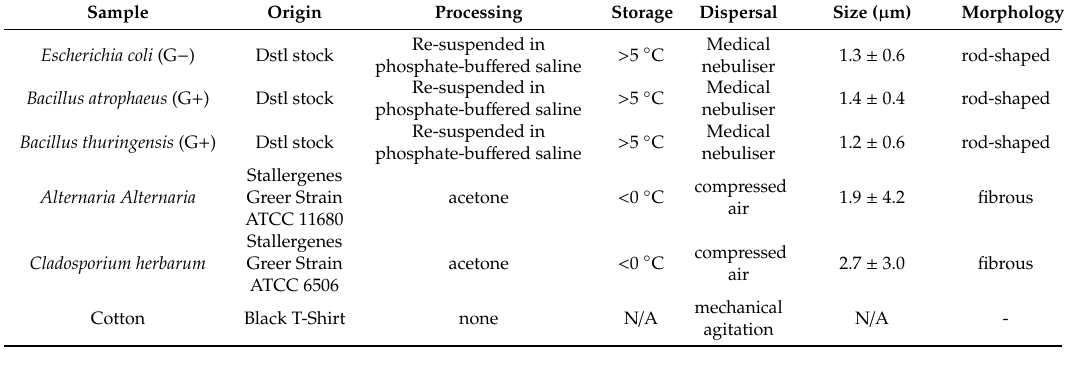
Table 1. Summary of training test aerosol, including source, sample processing, storage conditions, dispersal method, average size and morphology. Particle size was determined using an optical particle counter during the 2017 ACS characterisation experiments; see Forde et al., [23] for details. Details of any processing steps are provided in Section 3.1.